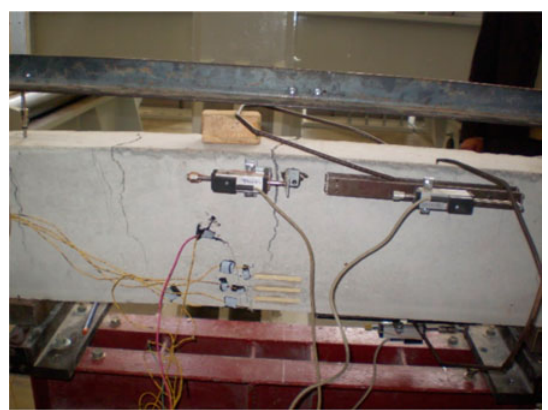
Fig. 7. General view of the test layout (the arrangement of measuring instruments)